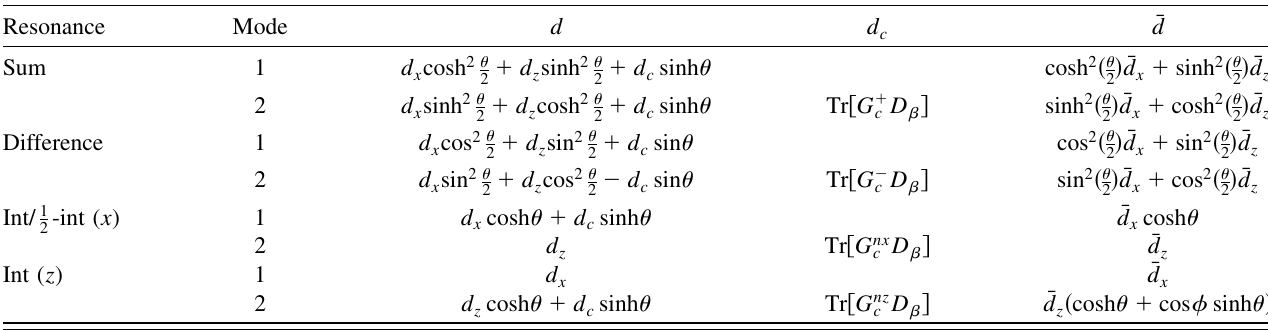
EQUILIBRIUM BEAM DISTRIBUTION IN AN . . TABLE IV. This table contains the diffusion coefficients near each of the linear resonances. The d column gives the local diffusion column gives the formula for the extra term d contained in the corresponding local diffusion coefficient for modes 1 and 2. The d c c coefficient. Finally, the (cid:3) d column contains the global diffusion coefficient which is given by integrating the local quantity. The text discusses the approximations used for these expressions. The angle (cid:16) is given by tan (cid:1) 1 (cid:2) (cid:4)= (cid:2) (cid:6) (cid:3) for the difference resonance and Table I.